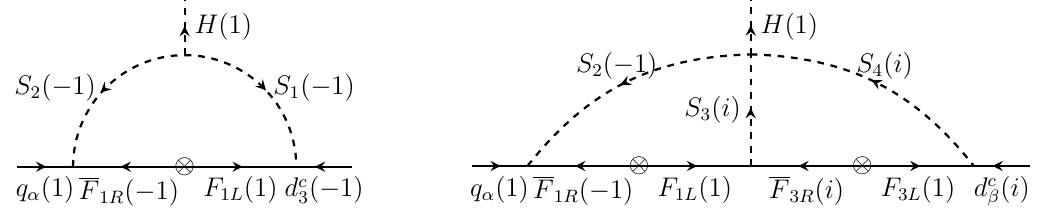
Figure 1 . One- and two-loop Feynman diagrams contributing to the entries of the SM down-type quark mass matrix. Here (cid:11) = 1 ; 2 ; 3 and (cid:12) = 1 ; 2. The charge assignment under Z 4 is explicitly given in parentheses. This symmetry is broken softly by the vector-like masses denoted by